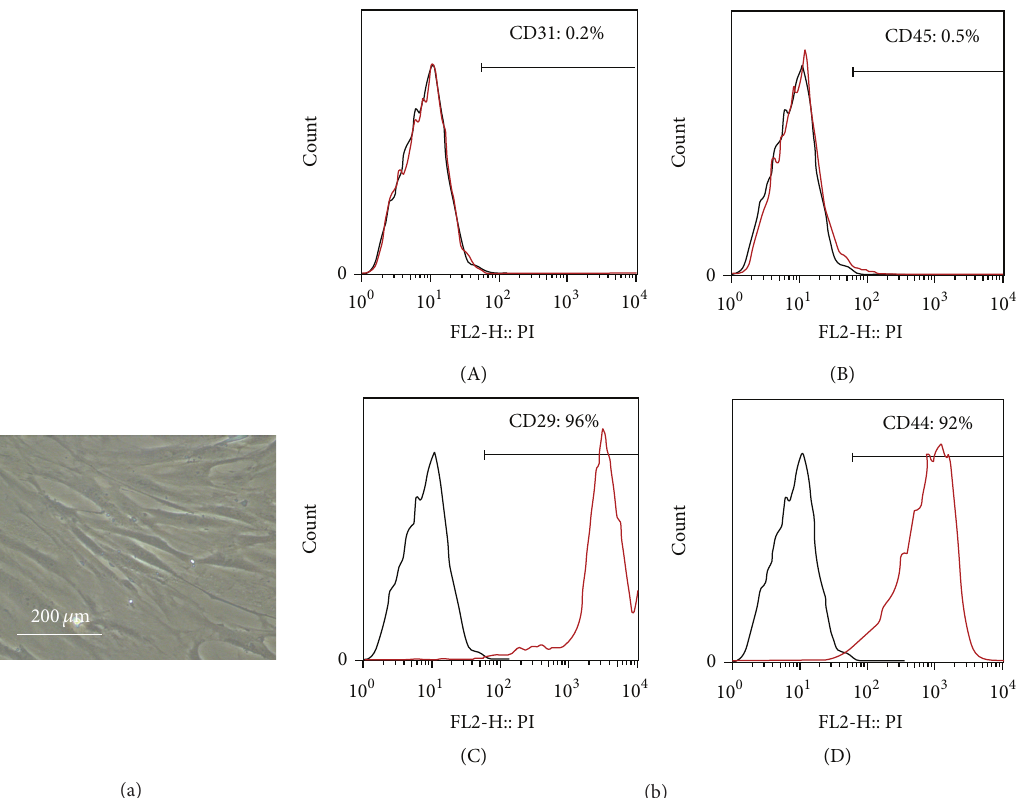
Figure 1: Morphology, flow cytometric analysis of AdMSCs. (a) Phase-contrast image of AdMSCs. (b) Flow cytometric analysis showed that cultured AdMSCs expressed CD29, CD44, but not CD31 or CD45. Black lines indicate isotype control while red lines indicate positively stained cells of each